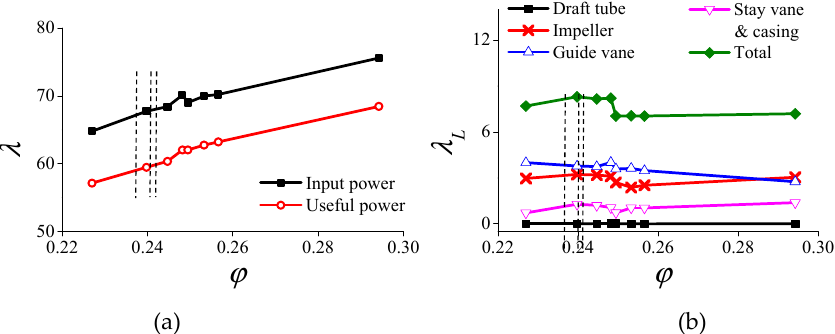
Figure 13. Performance and loss analysis. ( a ) Input power coefficients and useful power coefficient as well as ( b ) the loss coefficient in each component.